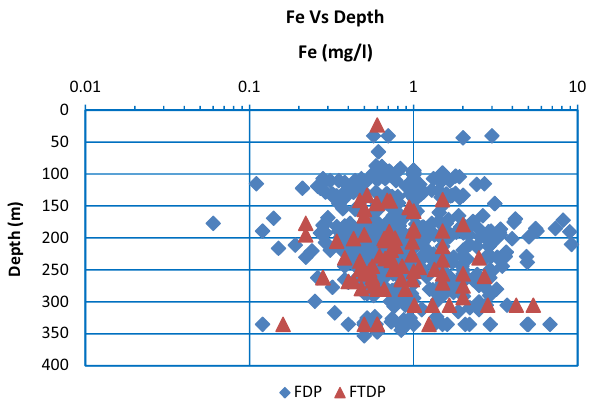
Fig. 11 Depth distribution of iron concentrations in groundwater of the study